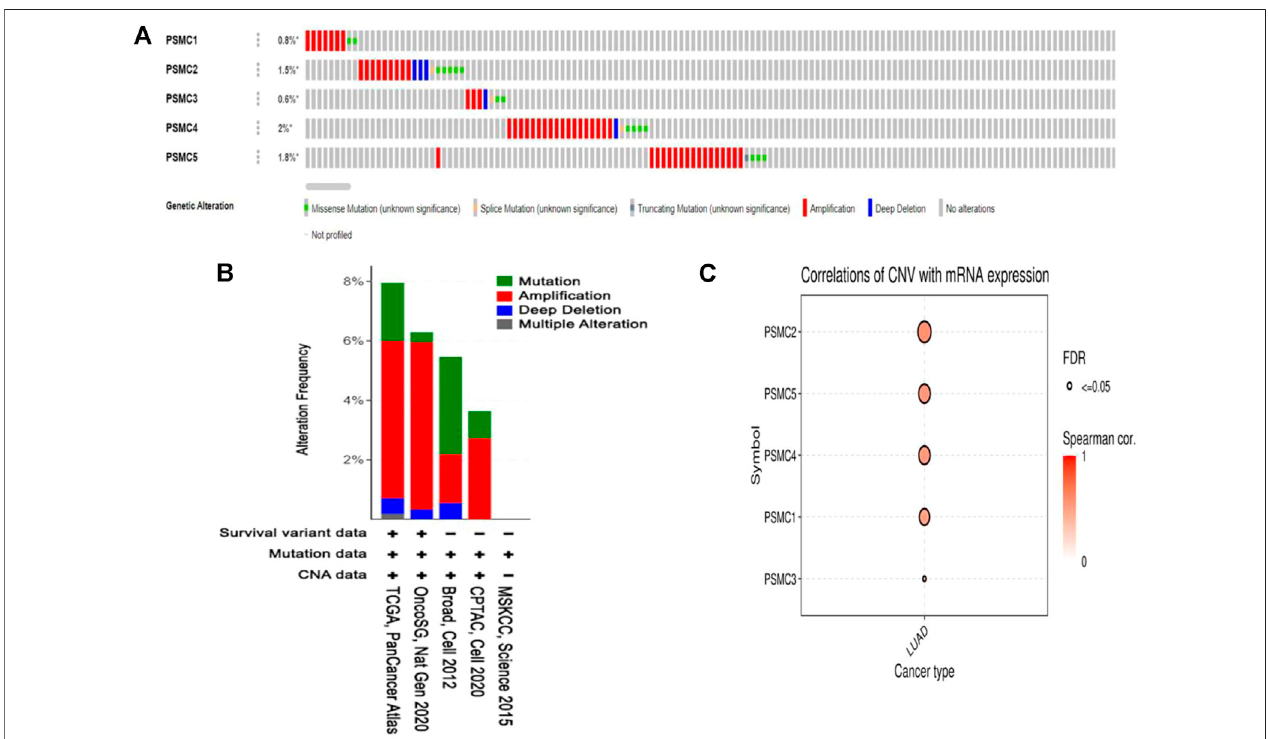
FIGURE 5 | Mutation analysis report on PSMC genes in LUAD patients presented in OncoPrint diagram (A) . The colored region of the column represents different alterations, and the alternation frequency is a fraction of the colored columns over the total columns. Ampli fi cation was found to be the most prevalent form of genetic alterationinall PSMC genesacrossdifferentLUADstudies.ThedistributionofmutationandCNAin PSMC genesacrossdifferentLUADstudiesisorientedinbardiagram (B) . The y -axis represents the percentage of total samples mutated in each LUAD study correspondingly presented in the x -axis. Bubble plot representing the positive correlation between the CNAs present in PSMC genes and their mRNA level expression in LUAD tissues (C)